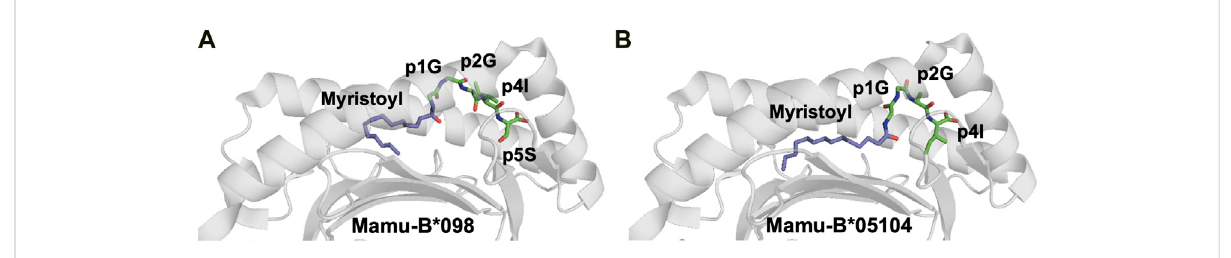
FIGURE 5 The myristoyl moiety in myristoylated peptides plays an essential role in both MHC-I binding and adequate presentation of the epitope (A) . The crystal structure of the rhesus macaque MHC-I molecule Mamu-B*098 in complex with the myristoylated 5-mer lipopeptide derived from SIV